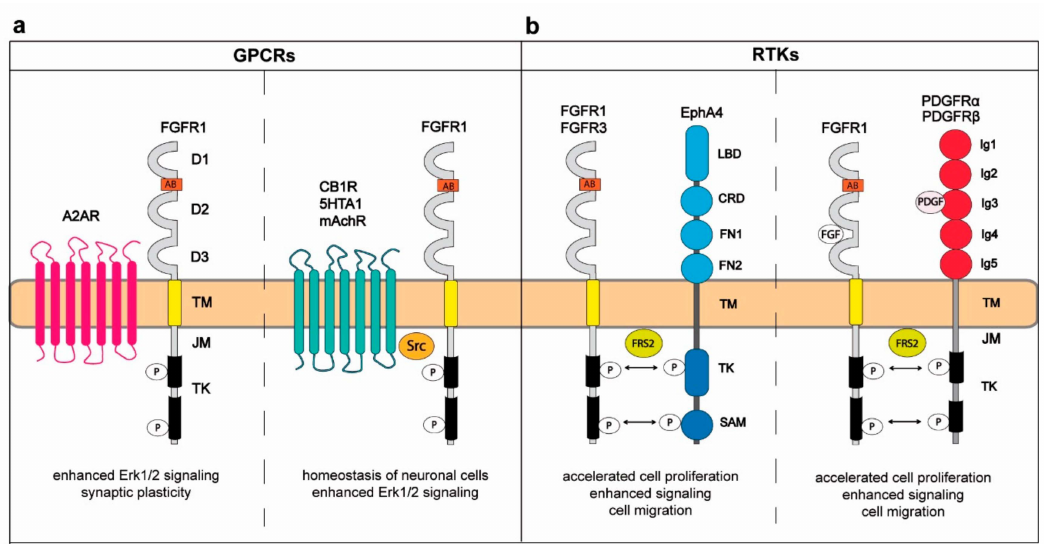
Figure 1. ( a ) Interplay between fibroblast growth factor receptors (FGFRs) and G-protein-coupled receptors (GPCRs) ( a ) and other receptor tyrosine kinases (RTKs) ( b ) in the regulation of downstream signaling. The extracellular region of FGFRs is composed of immunoglobulin like domains D1–D3 (gray) and the acidic box (AB; red). FGFRs are anchored in the plasma membrane by a single transmembrane helix (yellow). The cytosolic part of FGFRs consists of the juxtamembrane domain (JM) and the split tyrosine kinase domain (TK; black). GPCR–FGFR complexes may involve Src as a mediator between receptors or form functional heterocomplexes without involvement of Src. ( b ) FGFRs interact with other RTK members in the plasma membrane and can be directly activated by intracellular tyrosine kinase domains of partner proteins like Eph receptors or PDGFRs. EphA4 receptor contains the N-terminal ligand binding domain (LBD) followed by the cysteine rich domain (CDR) and two fibronectin type III domains (FN1–2). EphA4 is embedded in the membrane by a single transmembrane domain (TM). The cytosol-oriented region of EphA4 is composed of the tyrosine kinase domain (TK) and the sterile alpha motif (SAM). The TK domain of EphA4 interacts with JM region of FGFRs. PDGFRs contain five immunoglobulin-like domains (Ig1–Ig5) in their extracellular region, a single transmembrane span (TM), and intracellular juxtamembrane (JM) and tyrosine kinase (TK) domains. TK of PDGFRs directly phosphorylates